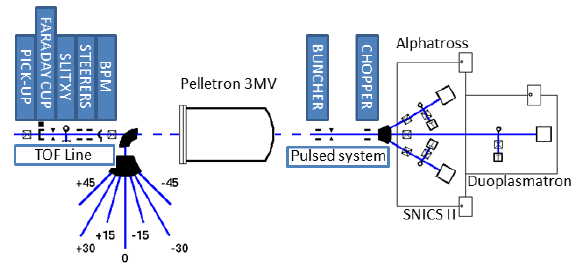
Figure 1. Schematic layout of the acceleration system and exper- imental beamlines after the upgrade, the new devices are high- lighted in blue.